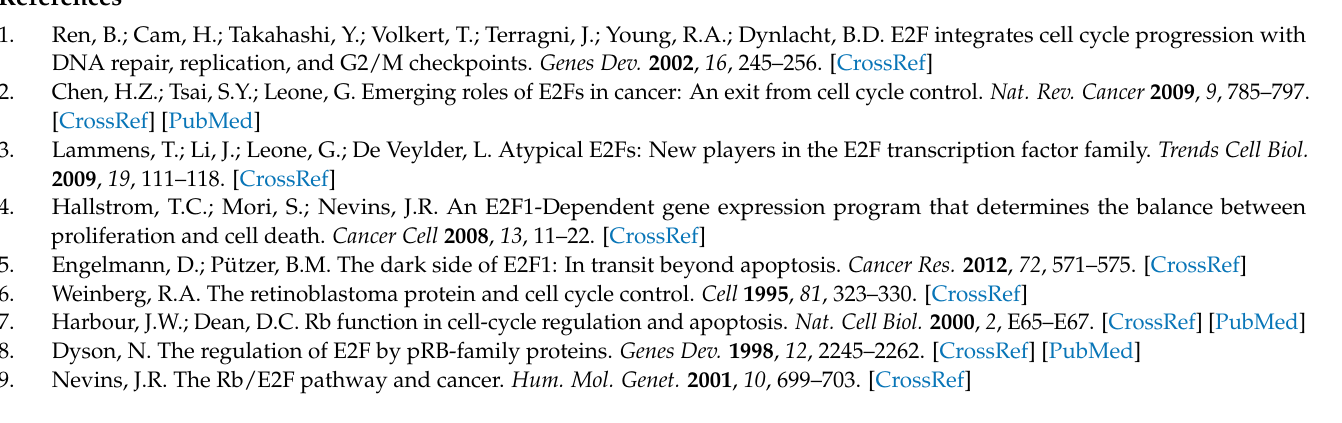
uncropped Western blots are shown. Figure S5: Release of D-Arg PEP from PEGylated liposomes. Means ± SD are shown. Figure S6: Effect of PEGylated liposomal D-Arg PEP (PL-PEP) against the H2009 cell line. Figure S7: Tumors extracted from the H2009 xenograft